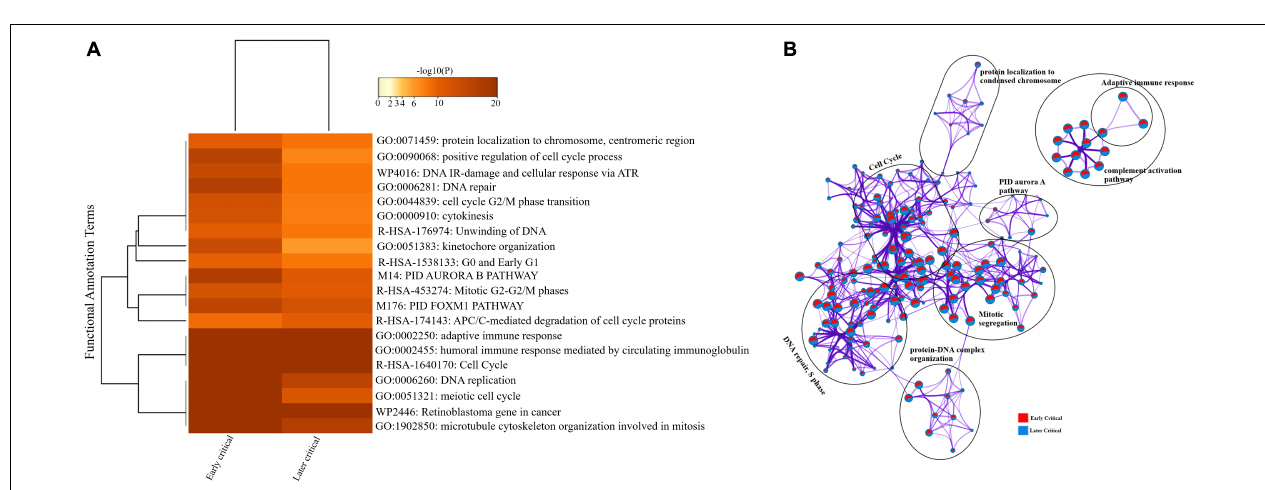
FIGURE 7 | Longitudinal analysis of early and later critical stages of SARS-CoV-2 infected groups. (A) Heat map displaying the top 20 enrichment clusters for early and later disease onset of critical COVID-19 groups colored by -log 10 (P) values using a discrete color scale representing statistical significance. The functional annotation terms and their corresponding categories are M (canonical pathways), GO (Gene Ontology), WP (Wiki pathways), R-HSA (Reactome Gene Sets), and hsa (KEGG pathway). (B) Network visualization of the enriched clusters for the list of DEGs generated by Metascape. The clusters were labeled manually. The pie chart color code describes gene lists’ identities, where the red color represents early critical patients, and the blue color represents later critical